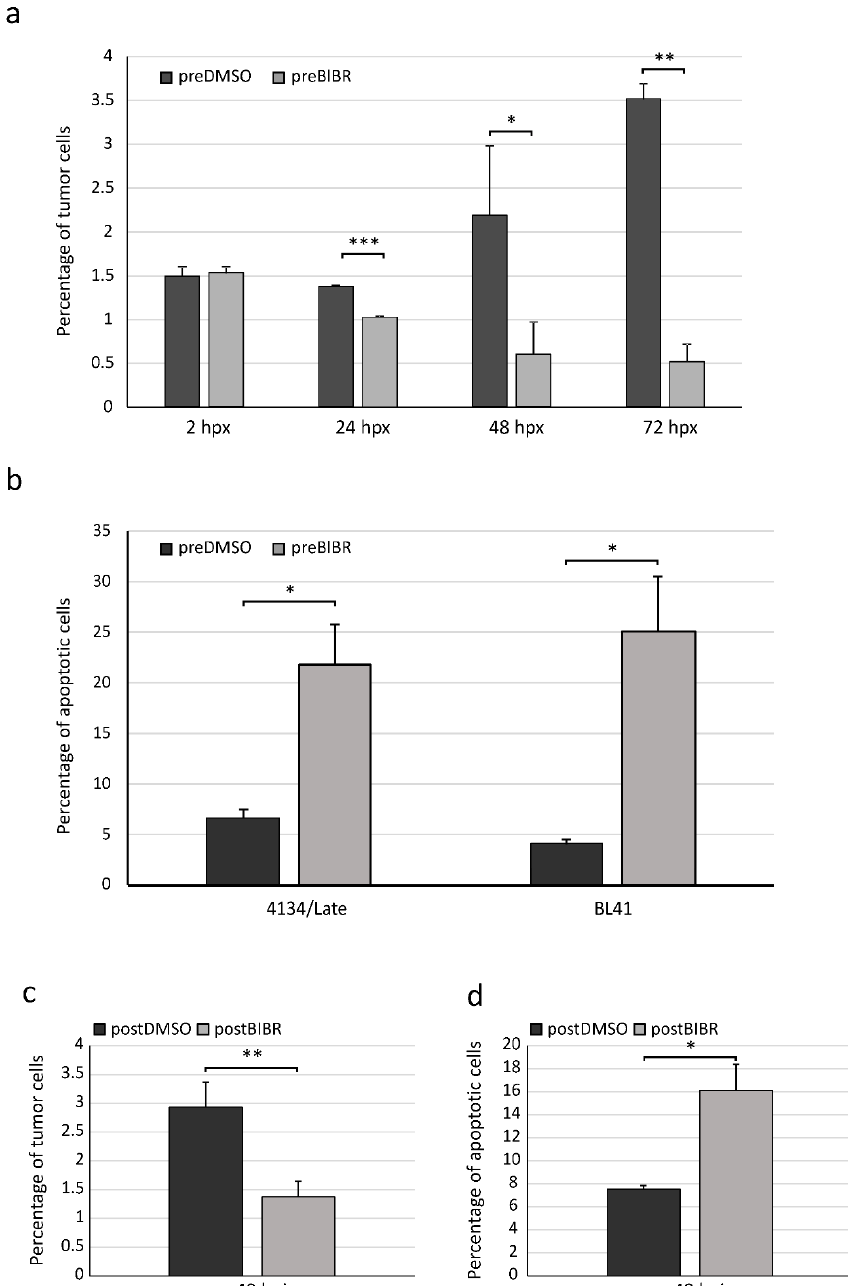
Figure 4. Effects of BIBR on proliferation and viability of tumor cells xenografted in zebrafish embryos. ( a and b ) Xenografted fluorescent tumor cells, pretreated with BIBR (preBIBR) or DMSO (preDMSO), were detected by flow cytometry in enzymatically dissociated embryos. ( a ) Percentage of 4134 / Late cells in zebrafish embryos according to time post-xenograft (hpx). Values are means and SD (bar) of three separate experiments of 10 embryos per group. ( b ) Cell suspensions from enzymatically dissociated embryos were processed by TUNEL assay for the detection of apoptotic cells. Histograms represent the percentage of tumor apoptotic cells (4134 / Late and BL41) at 72 hpx. Values are means and SD (bar) of two separate experiments of 10 embryos per group. ( c and d ) Twenty-four hours after transplantation, untreated 4134 / Late cells were injected with BIBR (postBIBR) or DMSO (postDMSO). Forty-eight hours after drug injection (hpi), fluorescent tumor cells were analyzed by flow cytometry in enzymatically dissociated embryos for proliferation ( c ) and apoptosis ( d ). * p < 0.05, ** p < 0.01 and *** p <